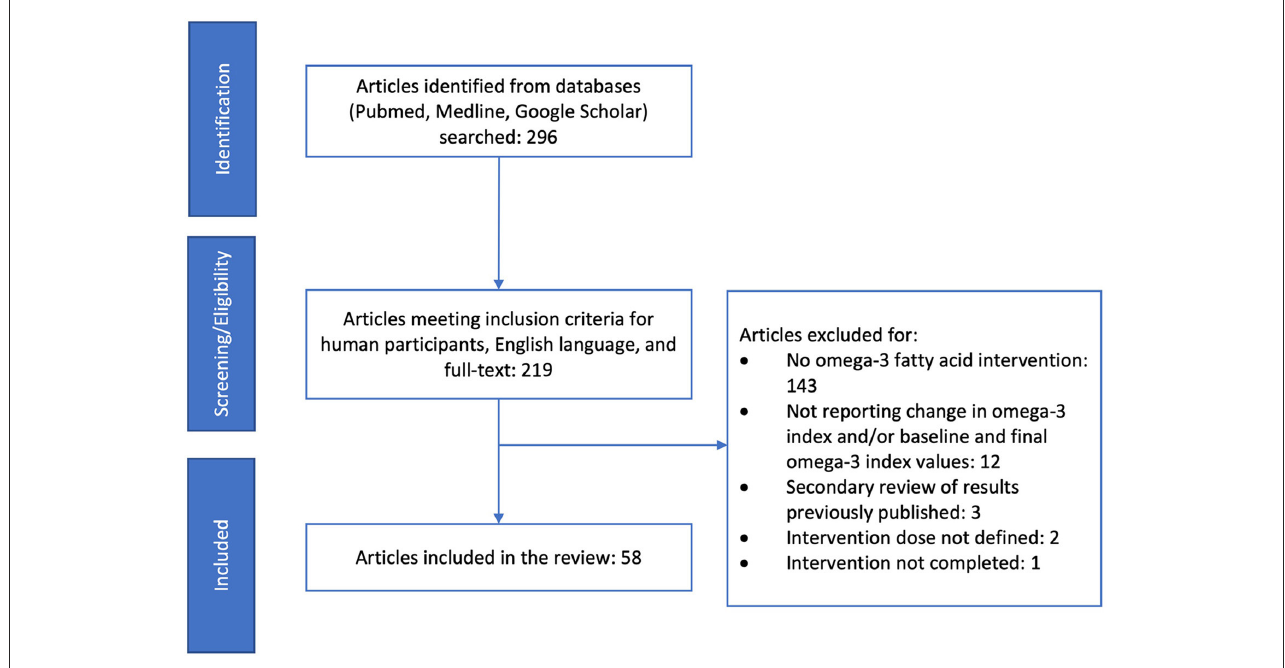
FIGURE1 PRIMSA flow chart showing study selection for scoping